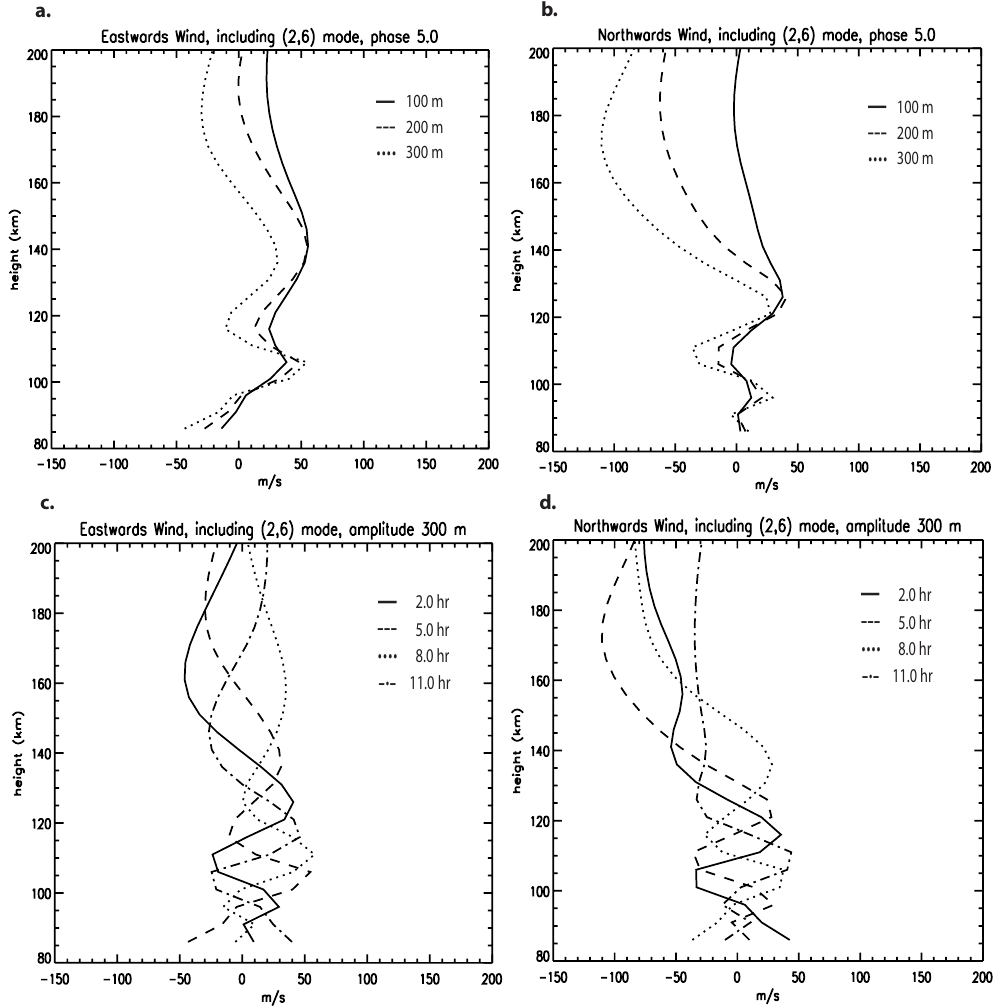
Fig. 3. (a) , (b) Response of the neutral winds to changes in the (2,6) mode tidal amplitude in the background winds, and (c) , (d) response of the neutral wind to changes in (2,6) mode tidal phase in the background